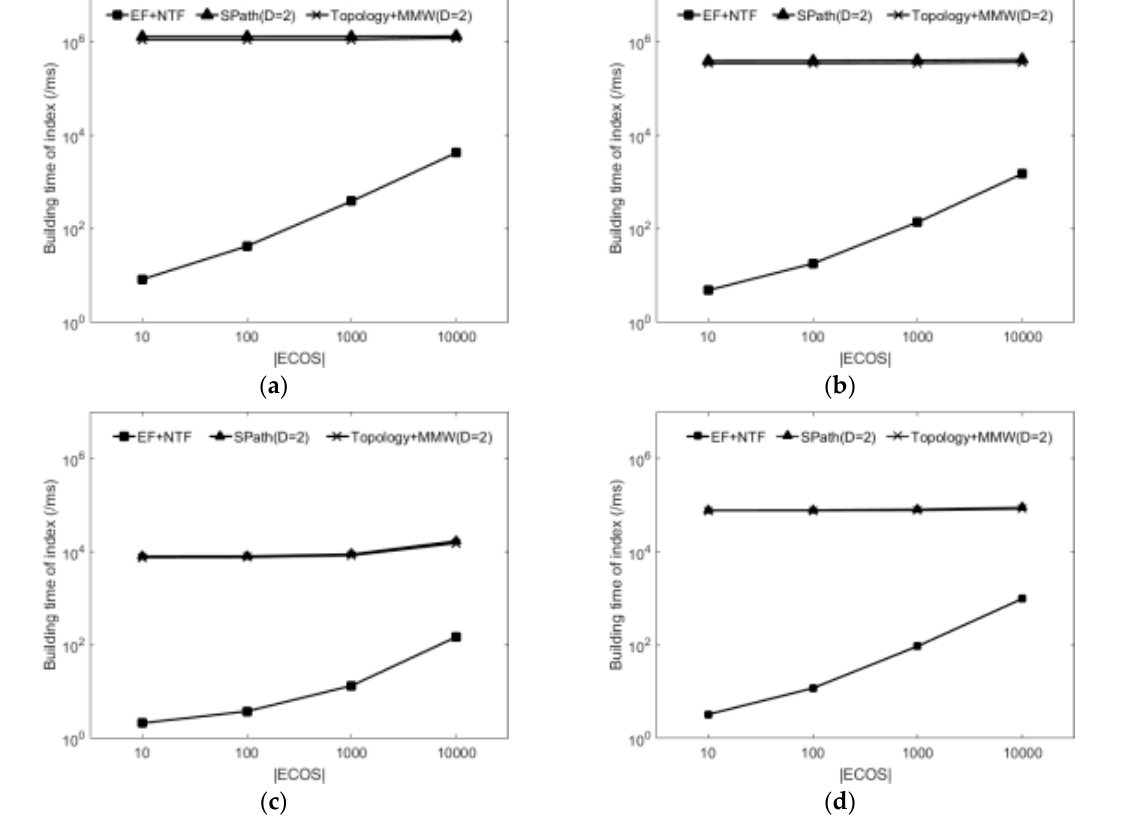
Figure 11. The comparison of index dynamic maintenance time. ( a ) Comparisons in DBLP; ( b ) Comparisons in Wordnet; ( c ) Comparisons in synthetic dataset G 1 ( d ) Comparisons in synthetic dataset G 2